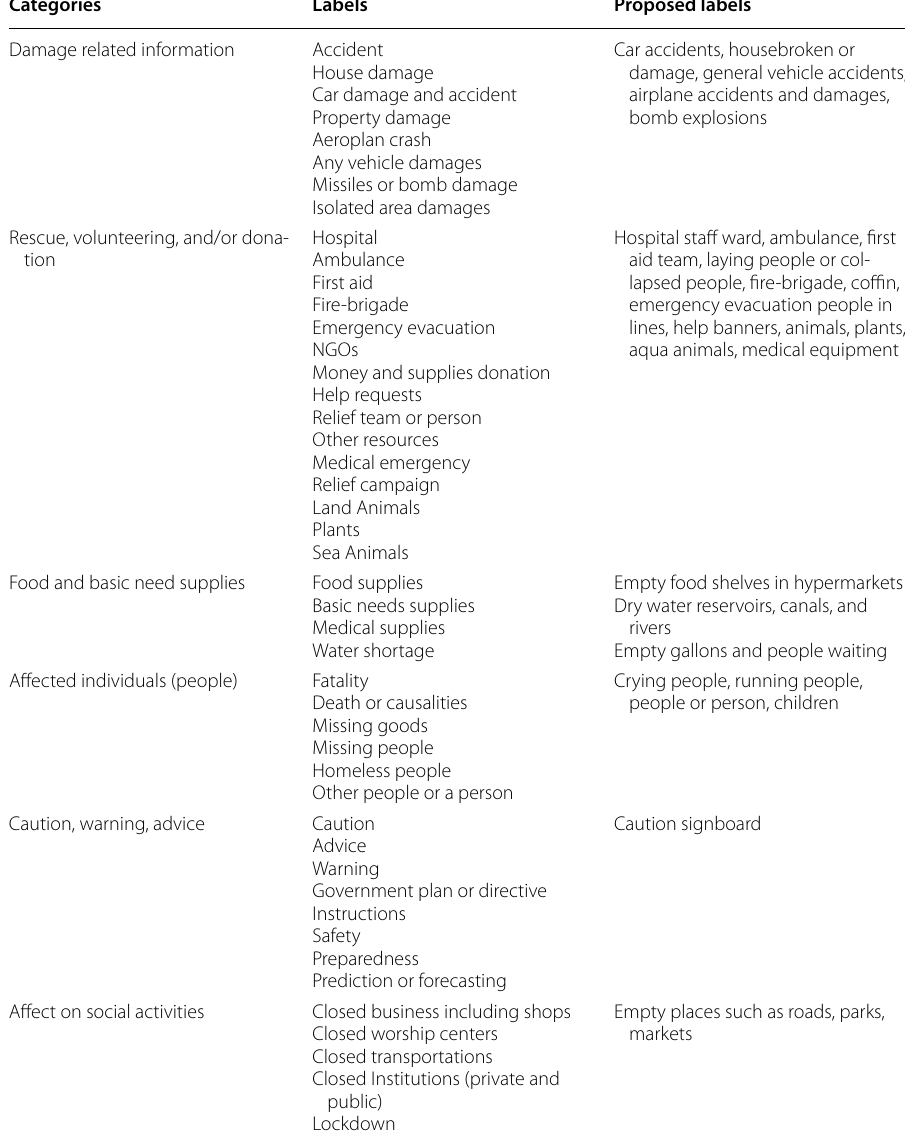
Table 4 The proposed disaster taxonomy